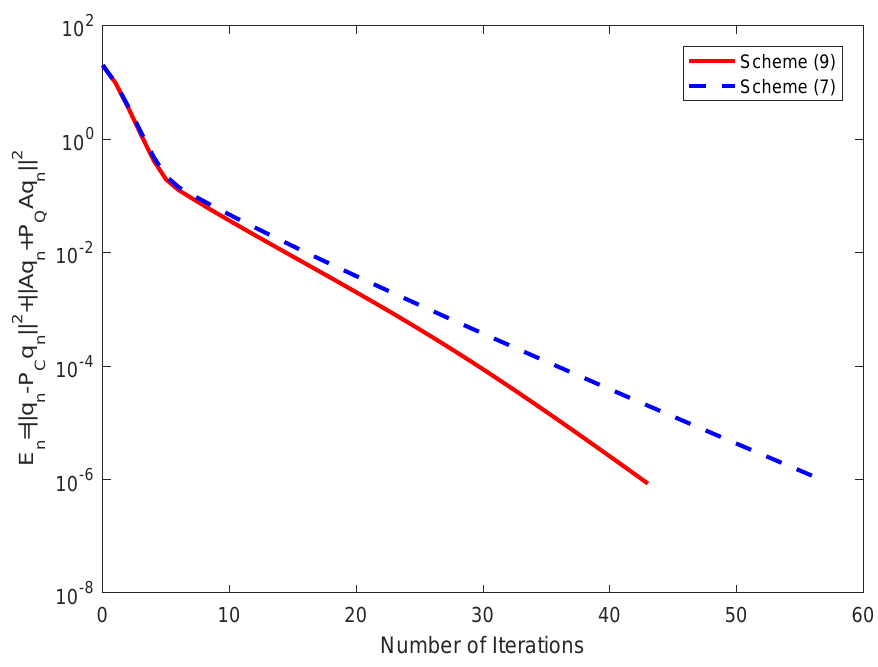
Figure 3. Comparison of scheme (9) and scheme (7) in Example 3, with q 1 = 4 t 2 + t +